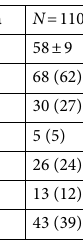
Table 3. Patient characteristics of Control group. The abbreviations are shown in Table